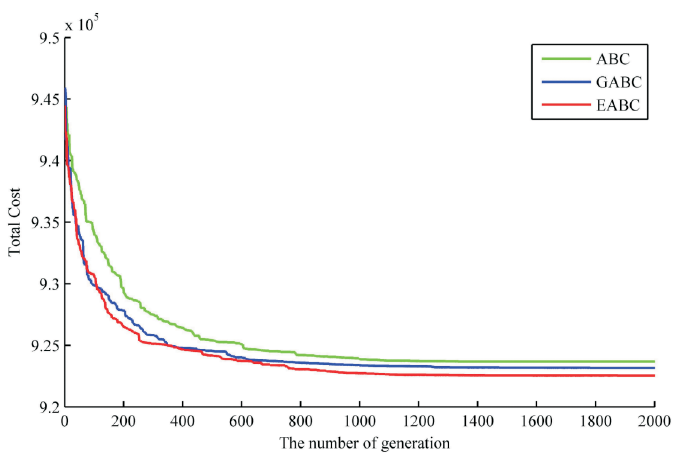
Fig 5. The optimization processes of the optimal solution with different